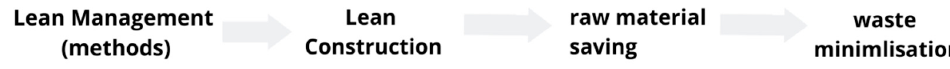
Figure 3. Waste minimisation from lean production concept.